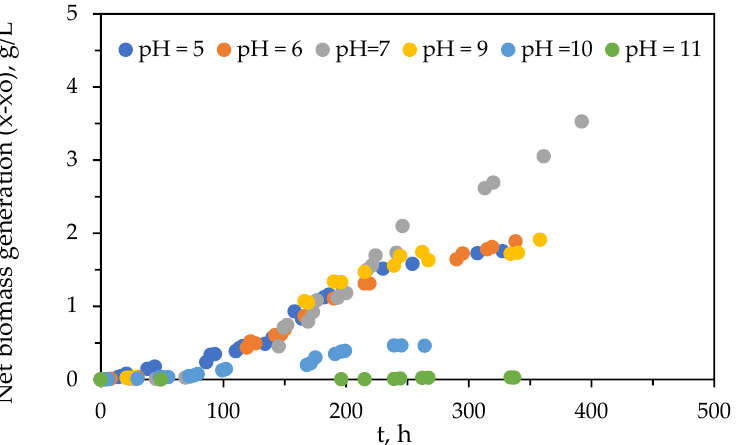
Figure 2. Net biomass generation (x − x o , g/L) of C. vulgaris growth in P-UW at different pH values. Operating conditions: P-UW (without dilution), mechanical stirring = 200 rpm, aeration rate = 0.5 L/min, T = 25 ◦ C and artificial illumination at 395 E/(cm 2 s). Note: The values presented correspond to mean values of at least three samples with a coefficient of variation (CV = standard deviation ∗ 100/mean) of less than 2%.